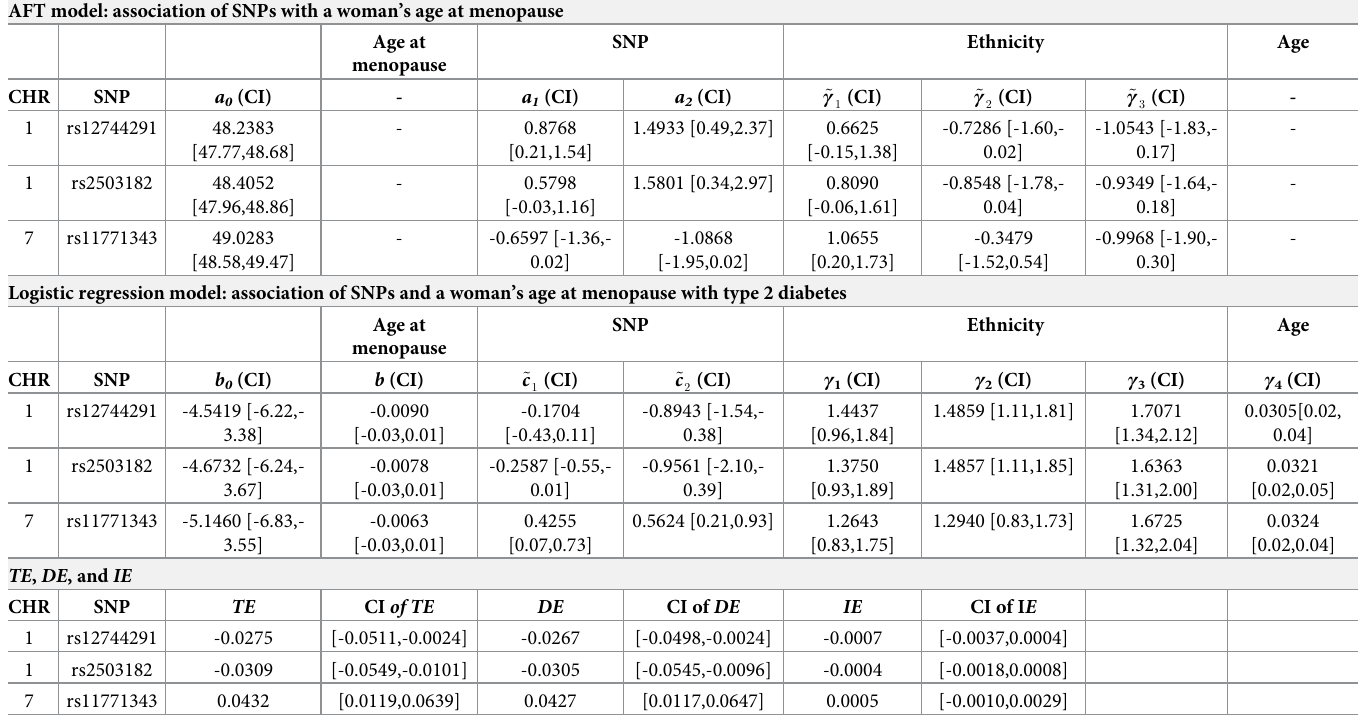
Table 5. Estimations of the coefficients, as well as the overall total effects ( TEs ), direct effects ( DEs ), and indirect effects ( IEs ), along with 95% confidence intervals (CIs), for the single nucleotide polymorphisms (SNPs) associated with both type 2 diabetes and a woman’s age at menopause in the real data analysis � . AFT model: association of SNPs with a woman’s age at